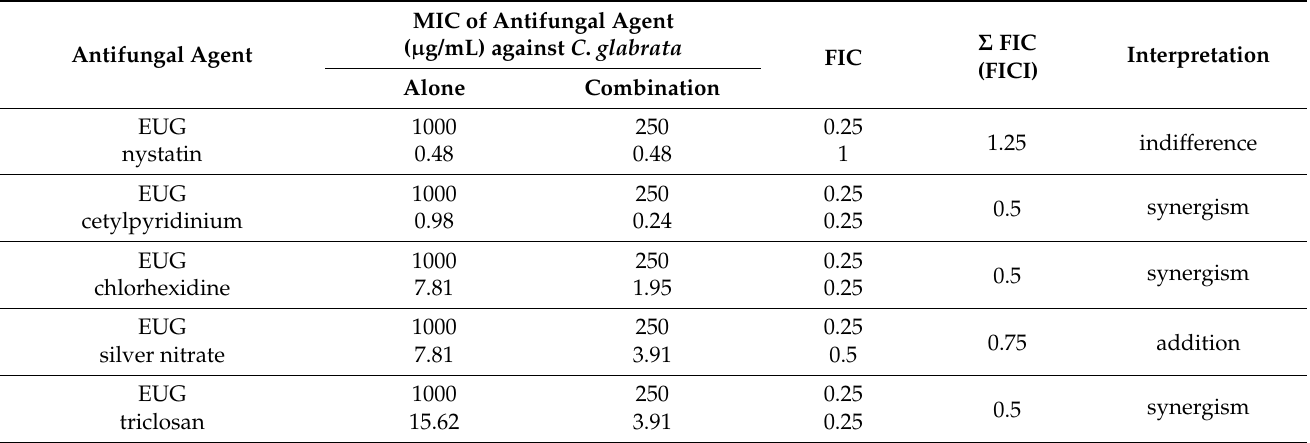
Table 10. MICs and FIC indices of EUG alone and in combination with selected antimycotics on reference C . glabrata ATCC 90030 strain.